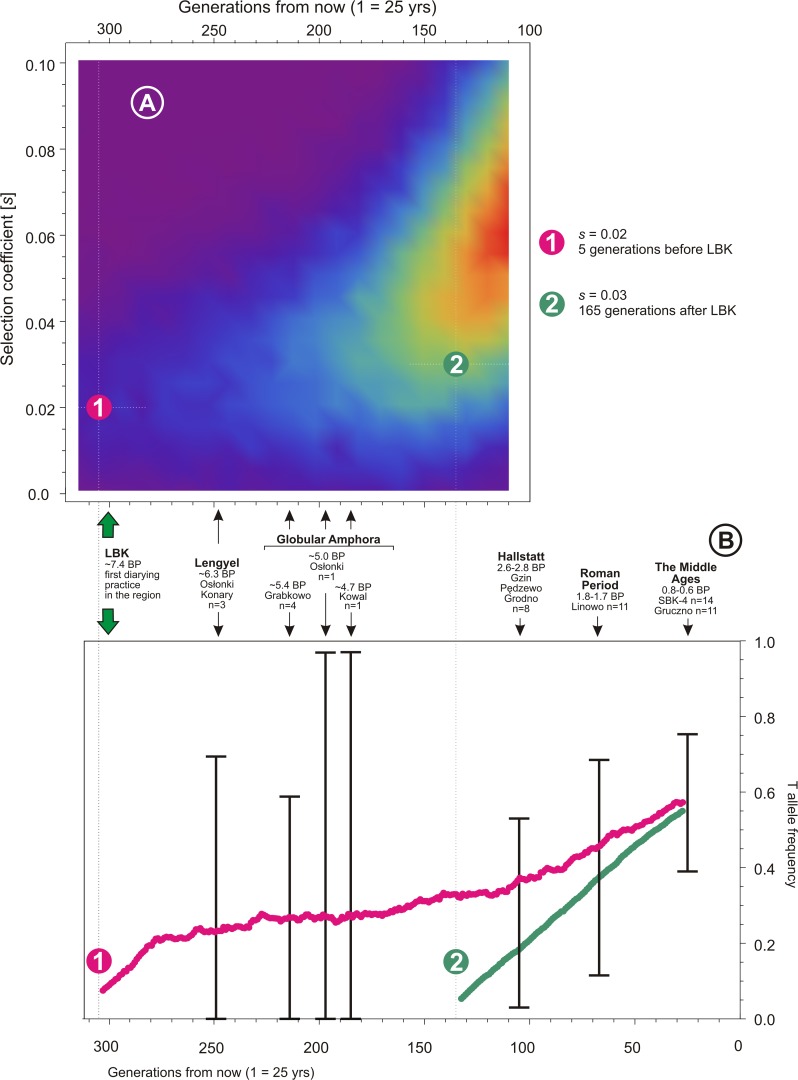
Mean allele frequency calculated for two chosen scenarios from Fig. 2A (only curves falling into confidence intervals were taken into account) along with their probabilities marked on the interpolated version of 2D part of Fig. 2A (curve 1—probability 0.027, curve 2—probability 0.297).